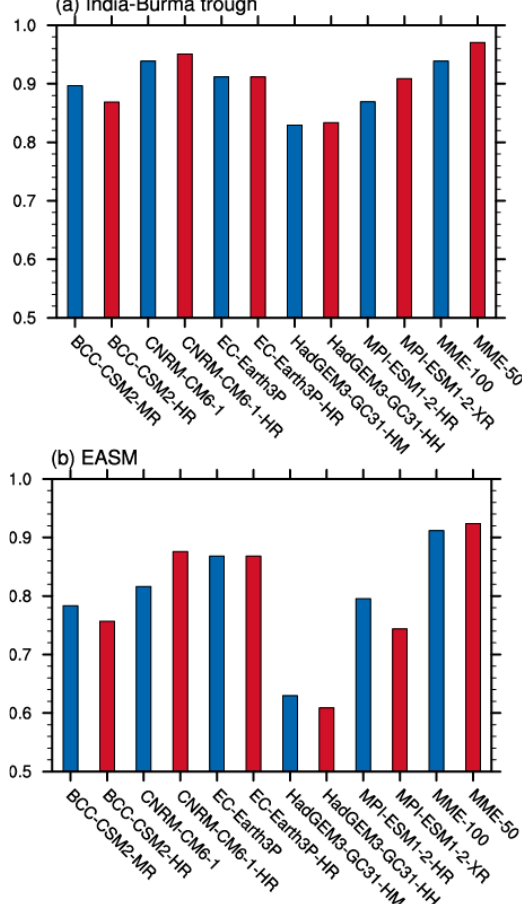
Figure 8. Skill scores of the climatological mean 850-hPa horizontal winds over (a) the Northern Bay of Bengal (80°–110° E, 5°–25° N) and (b) East Asia (0–50° N, 110°–160° E) in the observation, models, MME-100, and MME-50.